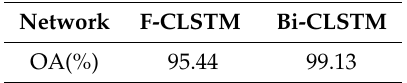
Table 7. OA of F-CLSTM and Bi-CLSTM on the KSC dataset.